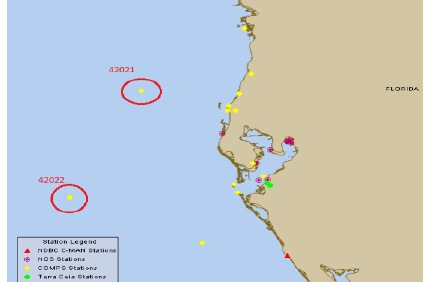
Figure 2. Two COMPS stations of in situ data in the Eastern Gulf of Mexico from NDBC. Station 42021-C14- Pasco County